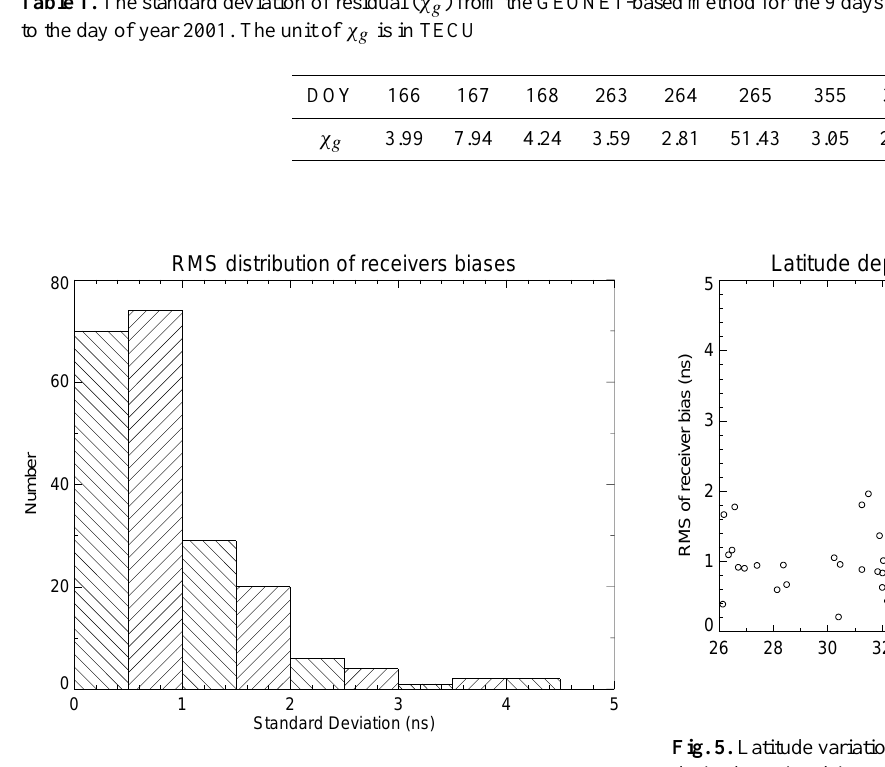
Fig. 4. Distribution of the standard deviation of the GEONET de- rived receiver biases from the 9-day mean. 93% of the cases are within 2ns.